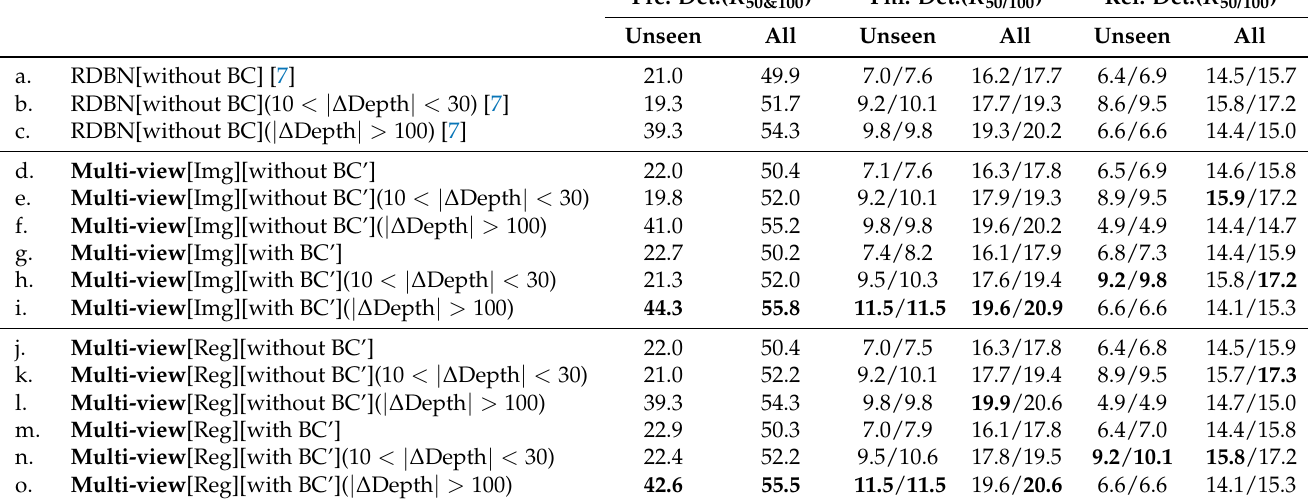
Table 2. Ablation study for multi-view information and proposed novel visual relationship balanced classifier BC’ (BC represents the balanced classifier proposed in RDBN [7]). [without BC’] represents VRD framework with traditional predicate classifier. Multi-view and Multi-view[Reg] represent multi-view VRD framework with ImageNorm and RegionNorm normalization strategy, respectively. The best performances of the framework with these two normalization strategies is highlighted in